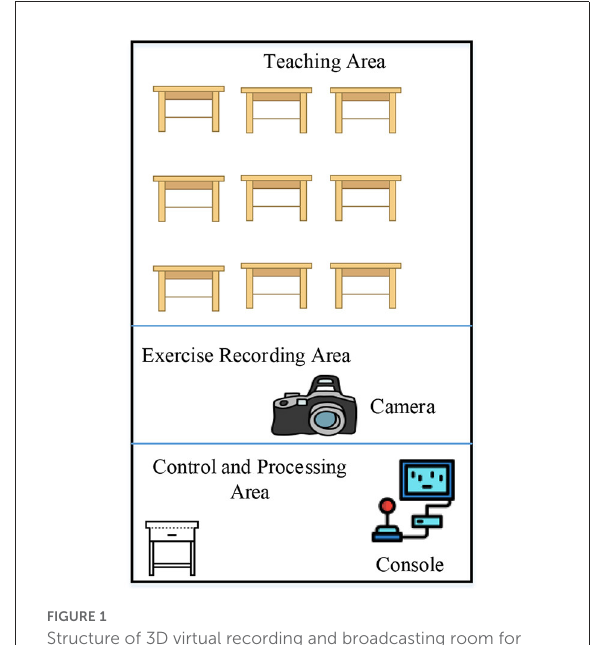
FIGURE1 Structure of 3D virtual recording and broadcasting room for Russian